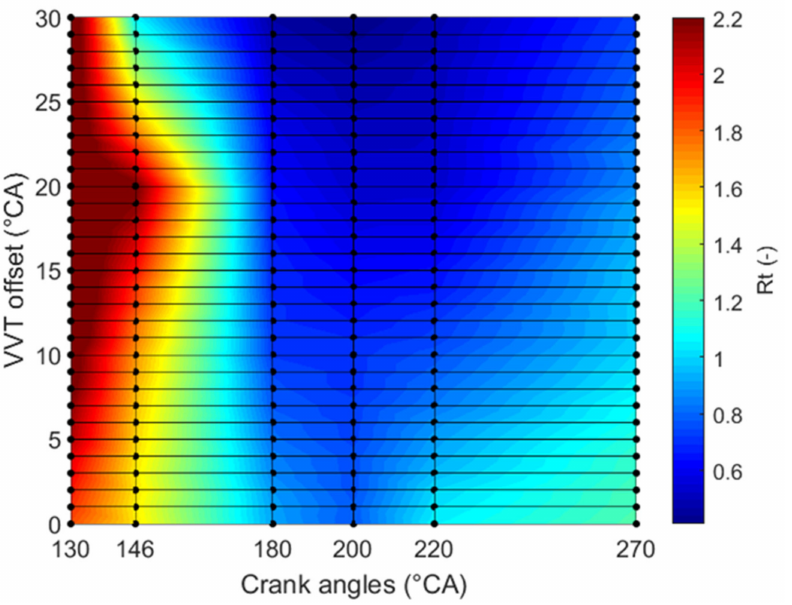
Figure 15. Mapping of rotation